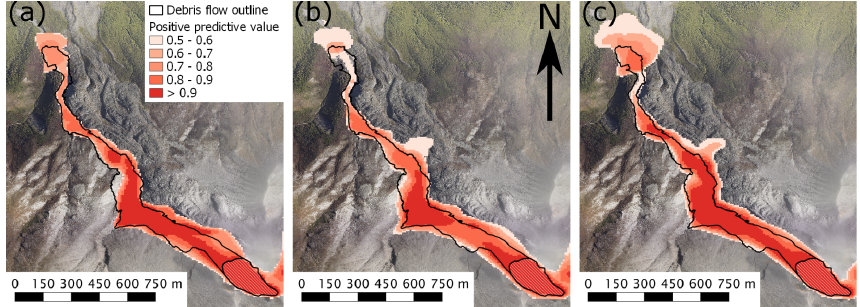
Figure 6. Positive predictive values for (a) Voellmy–Salm, (b) Pitman and Le (2005), and (c) Pudasaini (2012) simulations. The observed flow and source are outlined in black. Aerial basemap sourced from LINZ Waikato Aerial Photos 2012–2013.